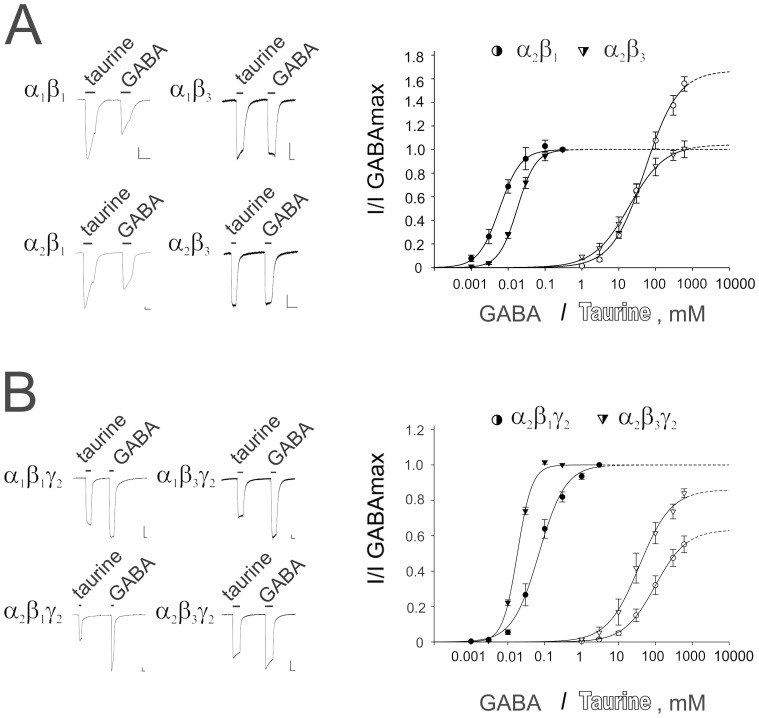
Comparison of taurine- and GABA-evoked maximal currents recorded from binary αxβx (A) or ternary αxβxγ2L (B) GABAA receptors.Note that gating by taurine of γ2 subunit containing GABAA receptors is significantly less efficacious compared to the corresponding binary receptors. Representative current traces (comparison of taurine (600 mM) - and GABA (0.1–1 mM) -evoked maximal currents at different receptor subtypes) are shown at the left. Scale markers represent 0.1 µA vertically and 20 s horizontally for all figures with oocyte recordings. Right: averaged concentration - response curves. Concentration of agonist (filled symbols for GABA -, open symbols for taurine - responses) is plotted versus normalized response amplitudes. Each individual measurement was first normalized to the observed maximal GABA - current amplitude and subsequently averaged. Number of investigated oocytes, Hill coefficients (nHill) and concentrations evoking a half - maximal response (EC50) are presented in Table 1.